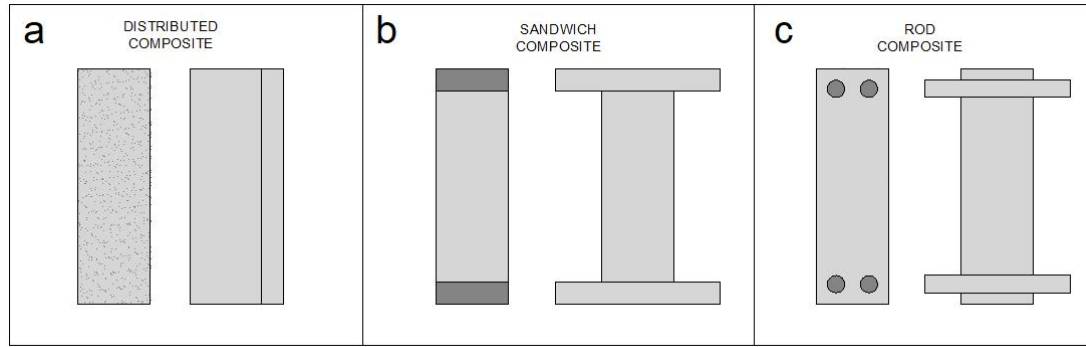
Figure 2. A comparison of the cross-section of different composite materials when transformed using the transformed sections method with Euler–Bernoulli beam theory. ( a ) The distributed particles sum to a increase in width in the transformed (right-side) section. ( b ) With sandwich composites, the stiffer material is placed at the extreme top and bottom, allowing the contributed area to increase the width at the extremities. ( c ) Rod composites have top and bottom cover included to allow for reinforcement protection.